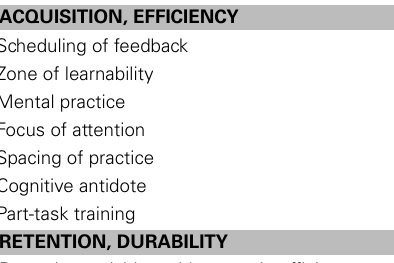
Table 1 | Training principles as a function of form of task engagement and training